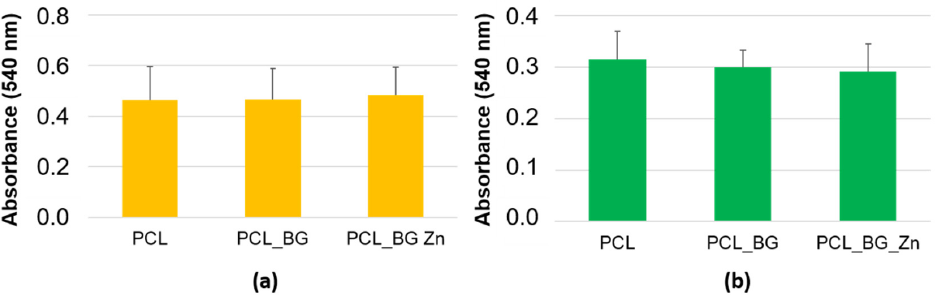
Figure 9. Cell viability was assessed by MTT assay. The results show a comparison of the cell viability of SaOS-2 cultured on individual materials for 24 h ( a ) and 7 days ( b ). Number of measurements: n = 9.